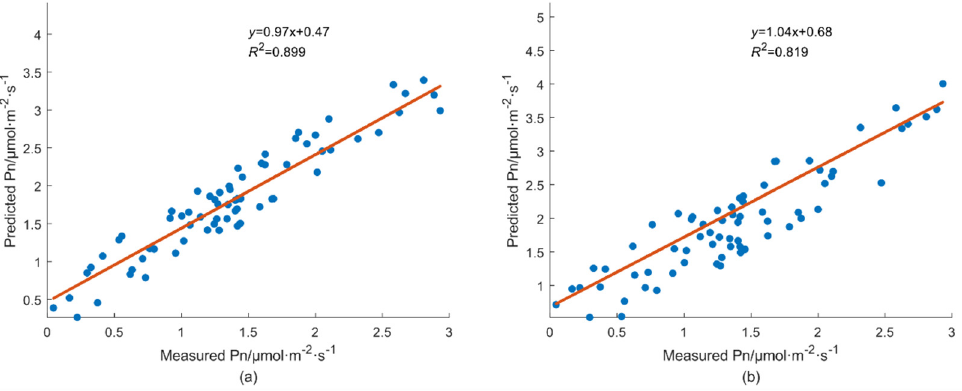
Figure 10. Fitting results: ( a ) MLSTM model result with the CWSI input feature; ( b ) SVR model result with the CWSI input feature.